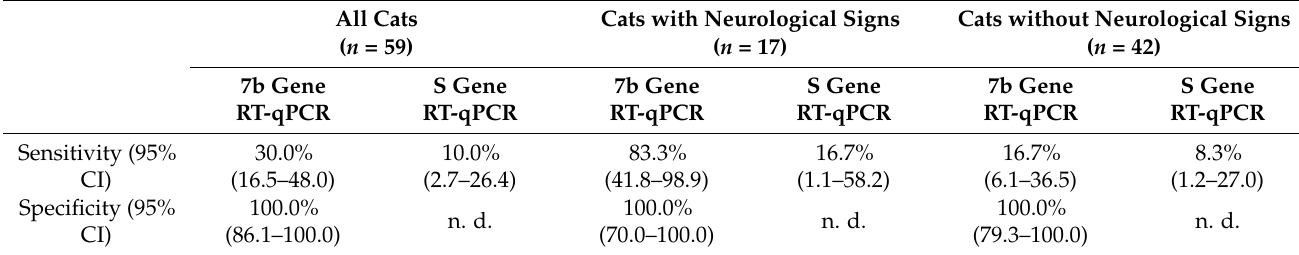
Table 4. Sensitivity and specificity of the 7b and spike (S) gene realtime reverse transcriptase polymerase chain reactions (RT-qPCR). S gene RT-qPCR was considered positive if mutated feline coronavirus (FCoV) or a mixed population of mutated and non-mutated FCoV was present within a